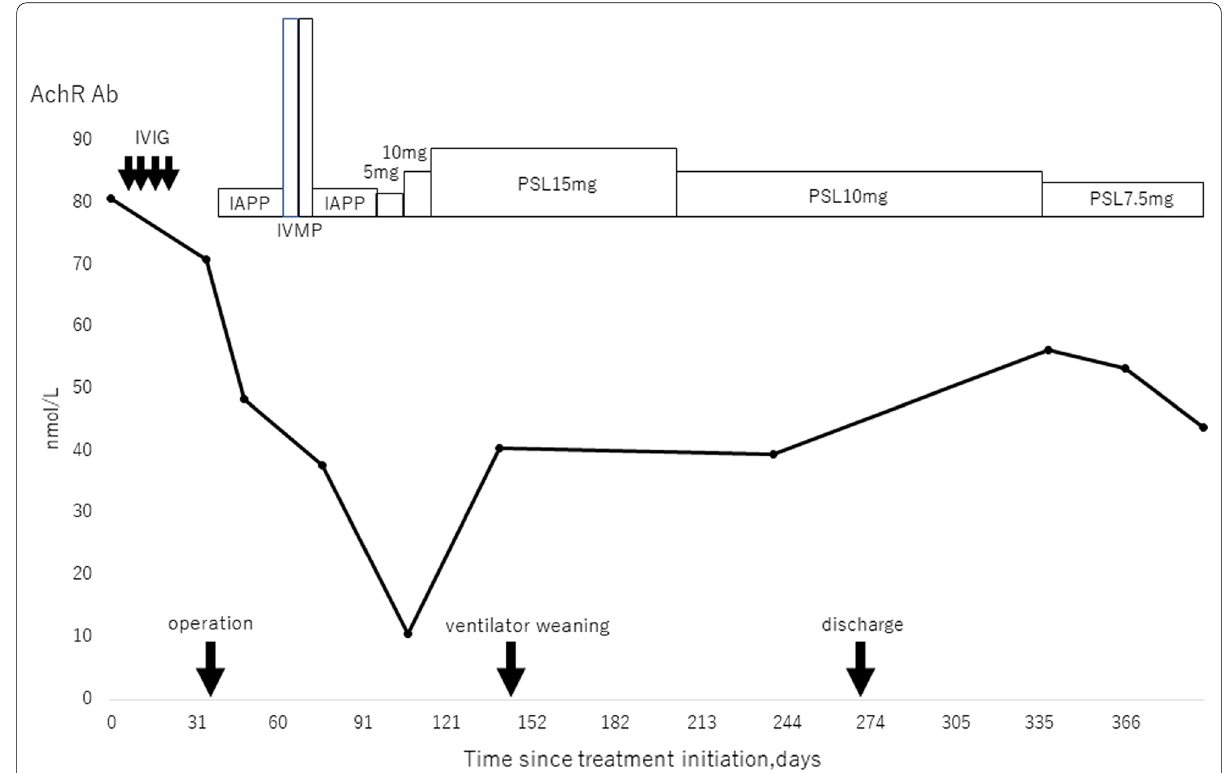
Fig. 3 Course of treatment and changes in the acetylcholine receptor antibody titer. Immunity therapy reduced the value and slowly improved the respiratory failure. IVIG intravenous immunoglobulin, IAPP immunoadsorption plasma pheresis, IVMP intravenous methylprednisolone, PSL